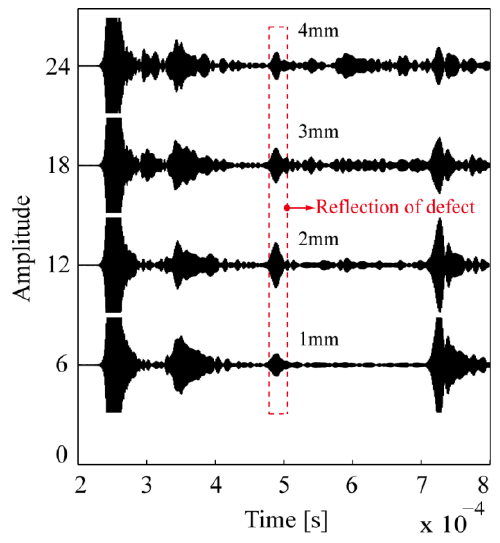
  0,2 L at 700 kHz versus damage size from 1 mm to